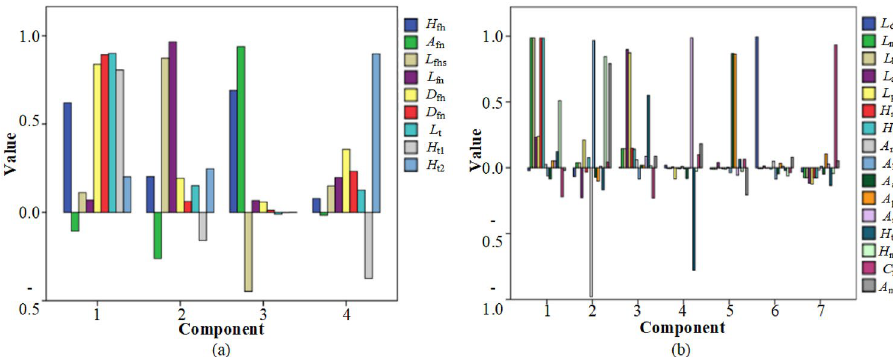
Figure 3. Rotated components of ( a ) proximal parameters and ( b ) distal parameters.